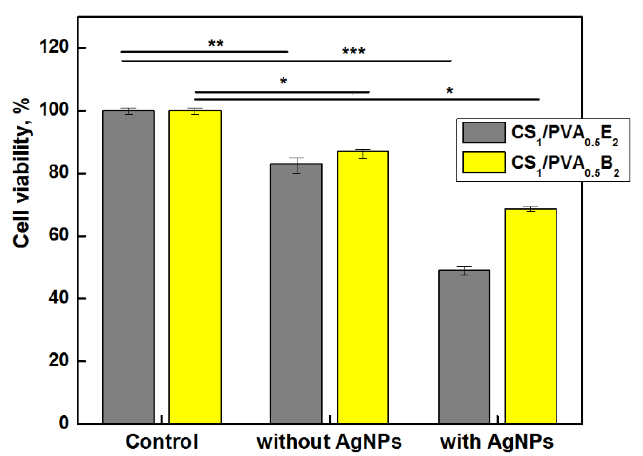
Figure 8. Cells viability of CS 1 /PVA 0.5 E 2 and CS 1 /PVA 0.5 B 2 hydrogels ( t T = 24 h) with and without AgNPs (1 mM AgNO 3 ), after 24 h (* p < 0.001 ** p < 0.01, *** p <